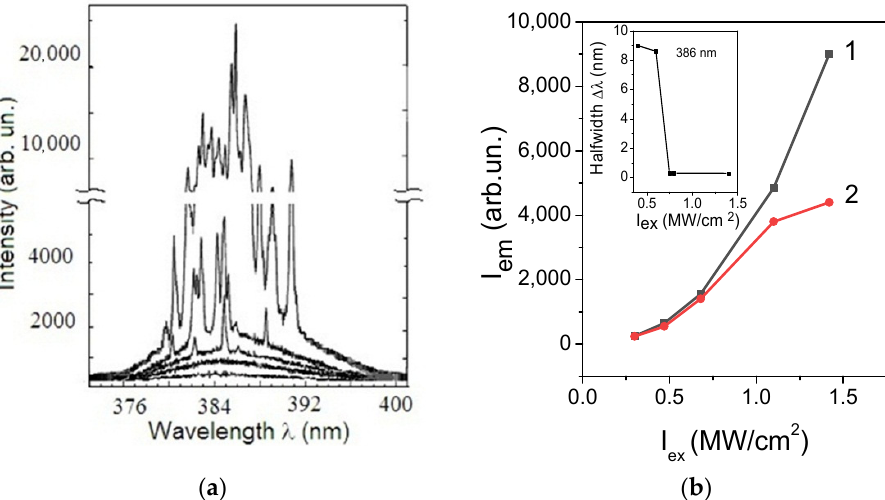
Figure 5. ( a ) UV PL spectra evolution of the monodispersed ZnO powder under excitation intensity in the range (from bottom to top): 400, 562, 763, 875, and 1387 kW/cm 2 (taken from reference [26] with permission). The size of the ZnO crystallite is equal 100 nm; ( b ) Dependencies of UV PL I em : (1)—the spectral-integral intensity of UV-PL emission; (2)—dependence of a separate ultra-narrow peak (386 nm) from monodispersed ZnO powder on the excitation intensity I ex ; inset: mean half-width of UV PL peaks as a function of I ex constructed from reference [26] with permission.